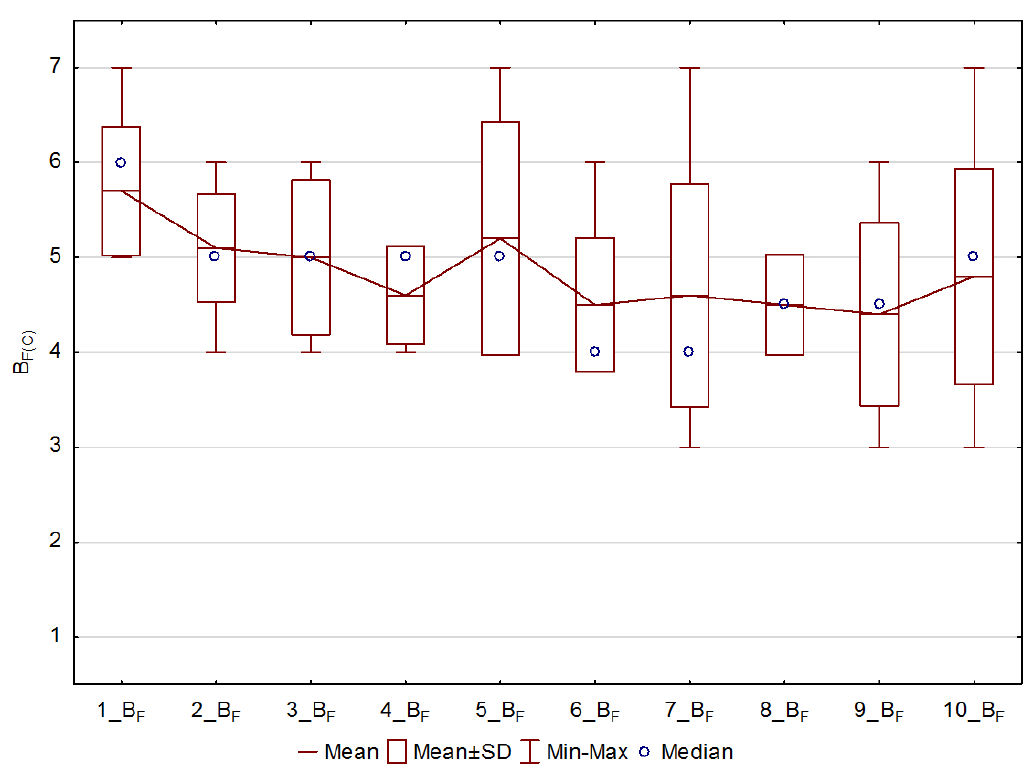
Figure 16. Floor brightness perception for group C.